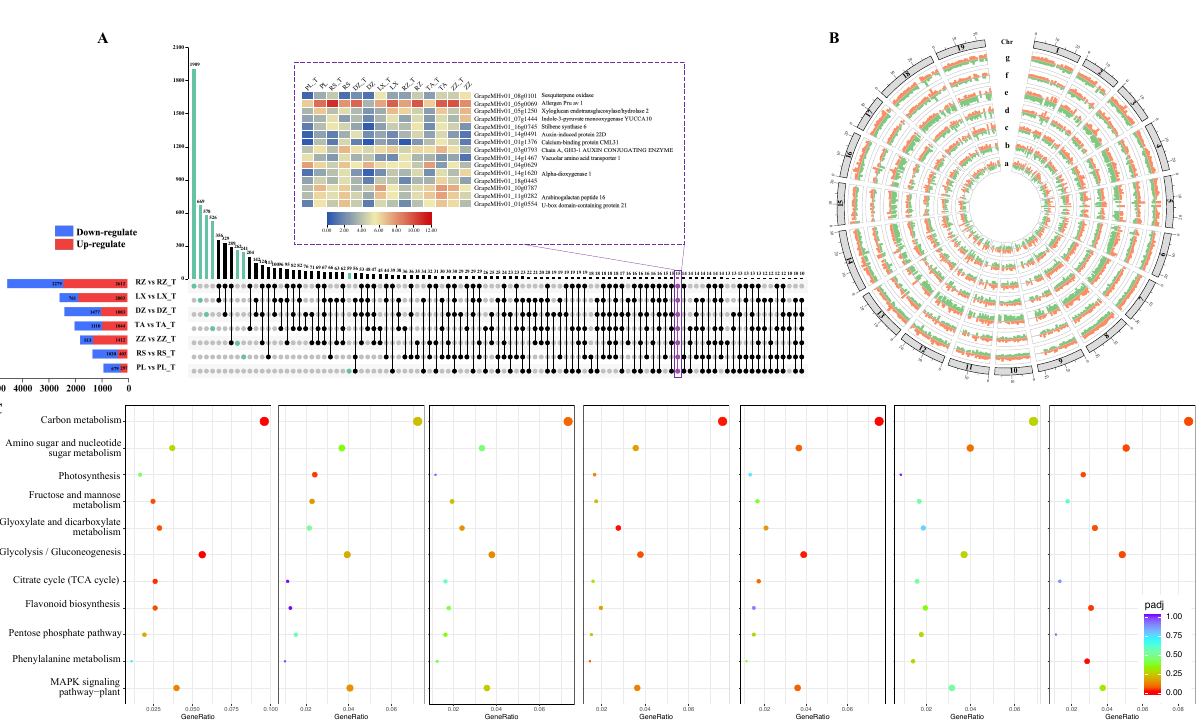
Figure 5. Determination of up- and down-regulated genes among the collected samples from seven regions. ( A ) Up-set showing the overlapping and unique genes of different regions, the blue column depicts down-regulate genes, the red column depicts up-regulate genes, and the heatmap represents DEGs based on FPKM (fragments of transcripts per million fragments mapped) value. ( B ) Circos diagram demonstrates the pattern of DEGs in different regions, which are labeled from a to g. The 19 chromosomes are shown by the first outer ring. The seven concentric rings from outside to inside represent the corresponding seven regions in this figure. Orange color in each cycle represents DEGs based on FPKM value at maturity, while green color represents DEGs at half-v é raison. ( C ) Plot shows the degree of enrichment of KEGG metabolic pathways in different regions. The abscissas represent the GeneRatio, and the ordinate represents KEGG pathway. The GeneRatio refers to the ratio of the sample number to the background number enriched in the pathway. The letters a–g called for PL vs PL_T, RS vs RS_T, ZZ vs ZZ_T, TA vs TA_T, DZ vs DZ_T, LX vs LX_T, and RZ vs RZ_T,